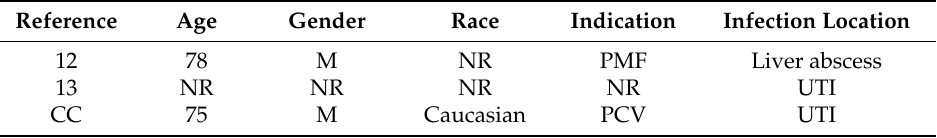
Table 1. Cases of K. Pneumoniae infections associated with ruxolitinib